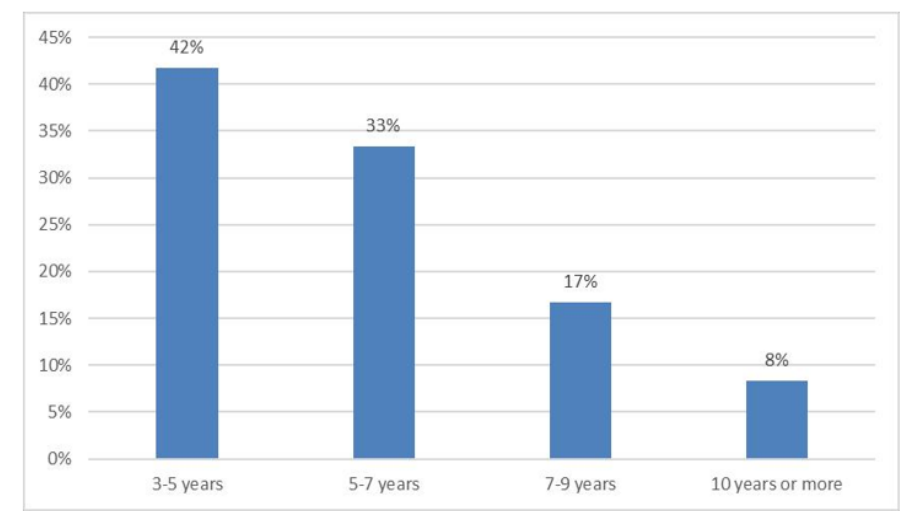
Figure 8. For How Long Have You Been Employed as a Supply Chain Manager in the Manufacturing Industry? (%)